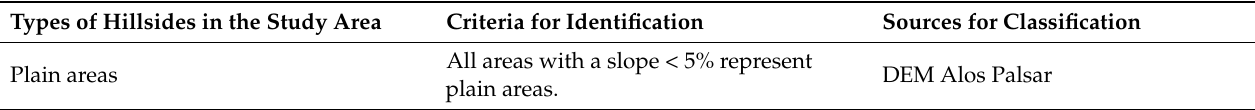
Table 1. Criteria and exclusive areas for the identification of degraded hillsides and their